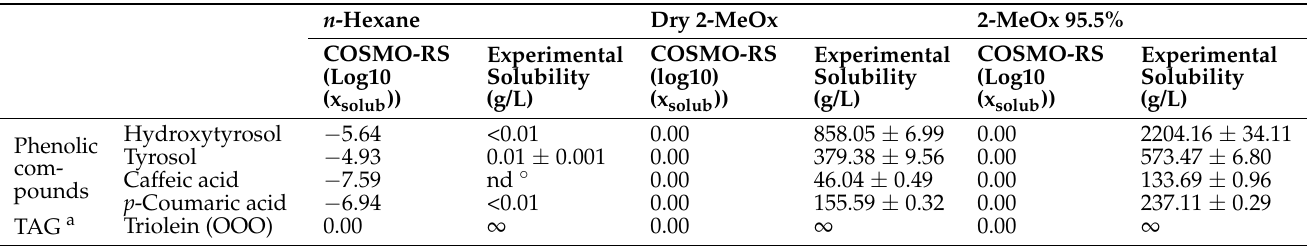
Table 1. COSMO-RS predicted solubility and experimental solubility at room temperature (25 ◦ C) of four phenolic compounds and Triolein (OOO) in n-hexane, dry 2-MeOx and 2-MeOx 95.5%. n -Hexane Dry 2-MeOx 2-MeOx